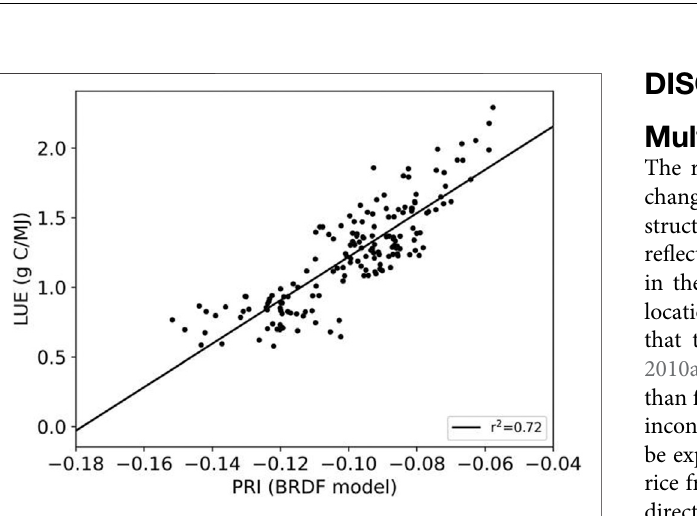
FIGURE 7 | Relationship between LUE and PRI corrected by BRDF. AfterusingtheBRDFmodeltocorrectPRI,thecorrelationwasimproved( R 2 = 0.72; p <